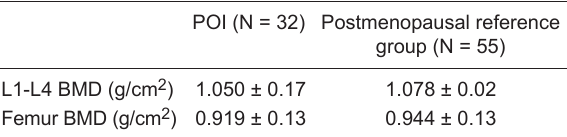
Table 2. Lumbar and femoral bone mineral density in the primary ovarian insufficiency and postmenopausal reference groups.